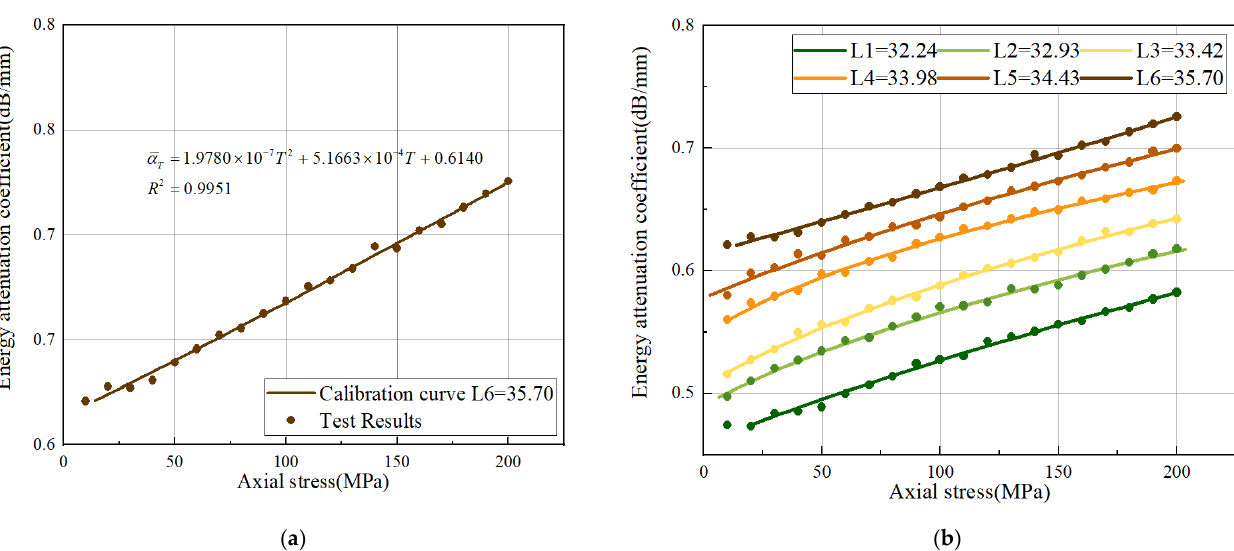
Figure 10. Fitting curves: ( a ) the calibrated curve of L6 = 35.70 in 8.5–9.5 MHz; ( b ) the calibrated curves of L1-L6 in 8.5–9.5 MHz.